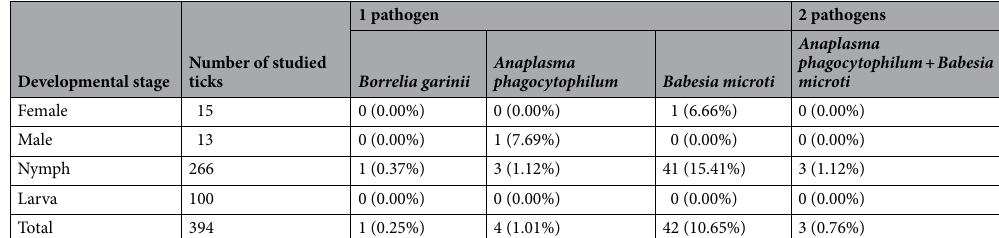
Developmental stage